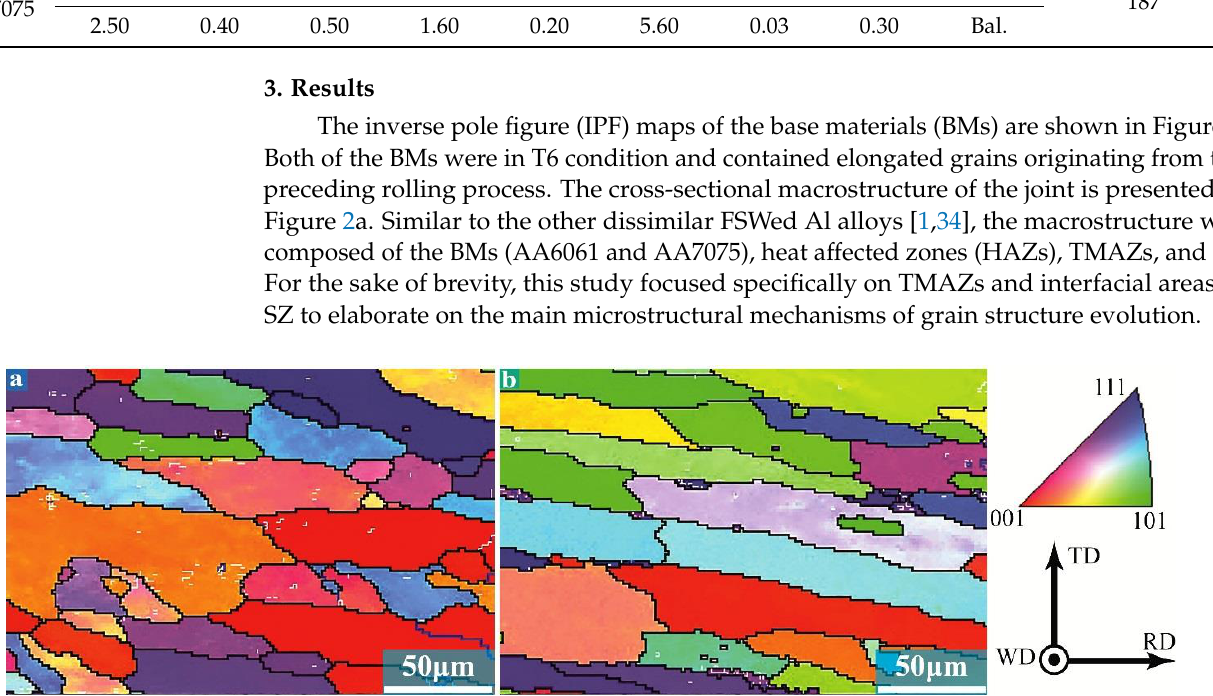
Figure 1. IPF maps of the BMs: ( a ) AA6061, and ( b ) AA7075. WD, TD, and RD are the abbreviations of welding, traverse, and rolling directions, respectively.